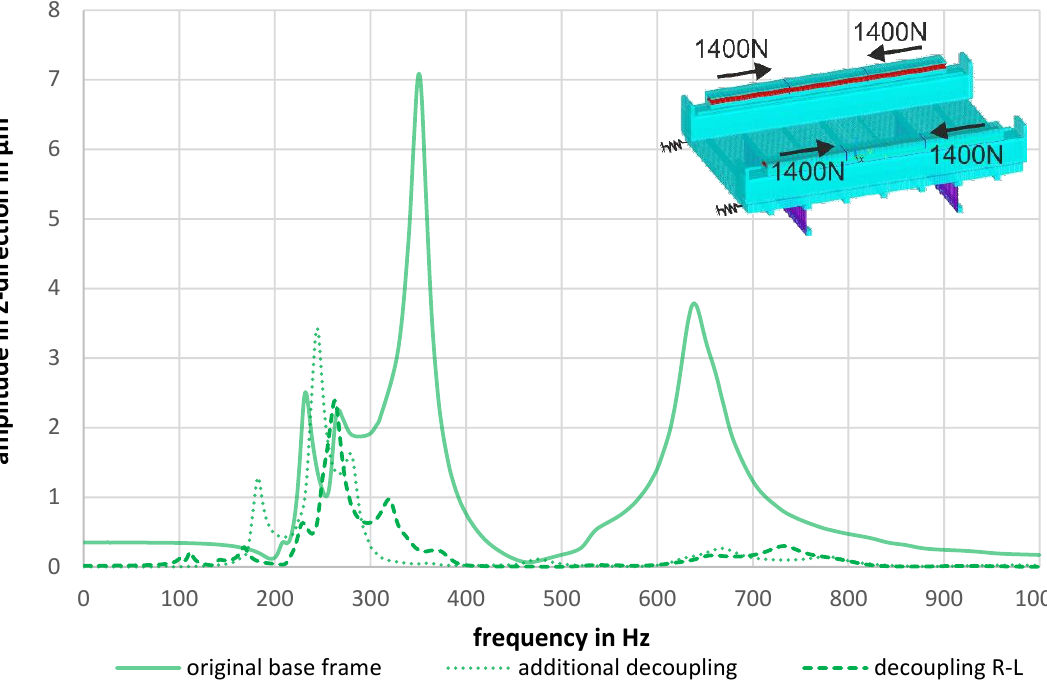
Figure 6. Frequency response of the frame vibration amplitude in Z-direction (at the location of the accelerometer, see Figure 2), excited by counteracting identical drive forces (ideal compensation).